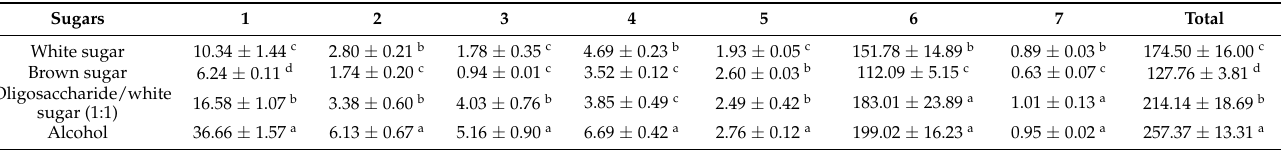
Table 4. Contents of seven lignans in Omija beverages or drink fermented with different